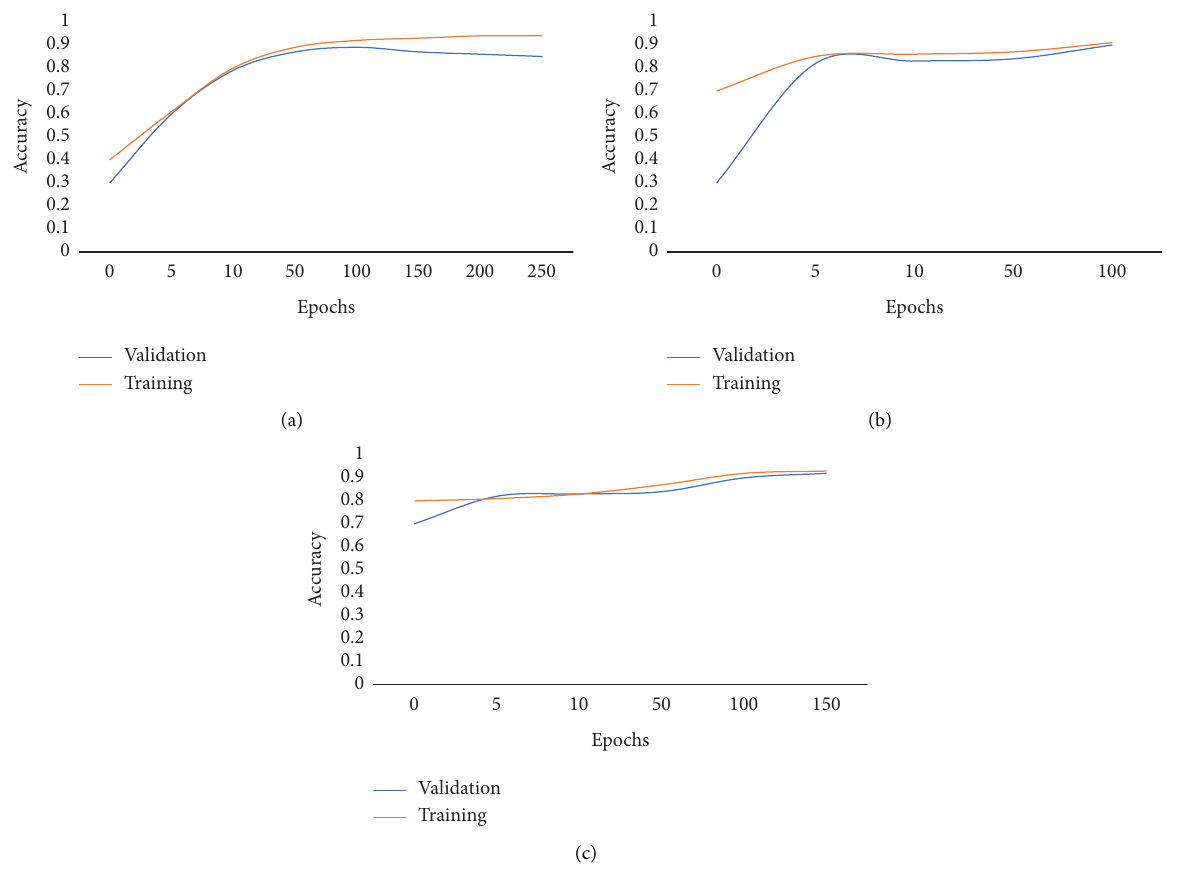
Figure 9: Training and validation error of each epoch. (a) Taobao dataset. (b) Instagram dataset. (c) IMDB